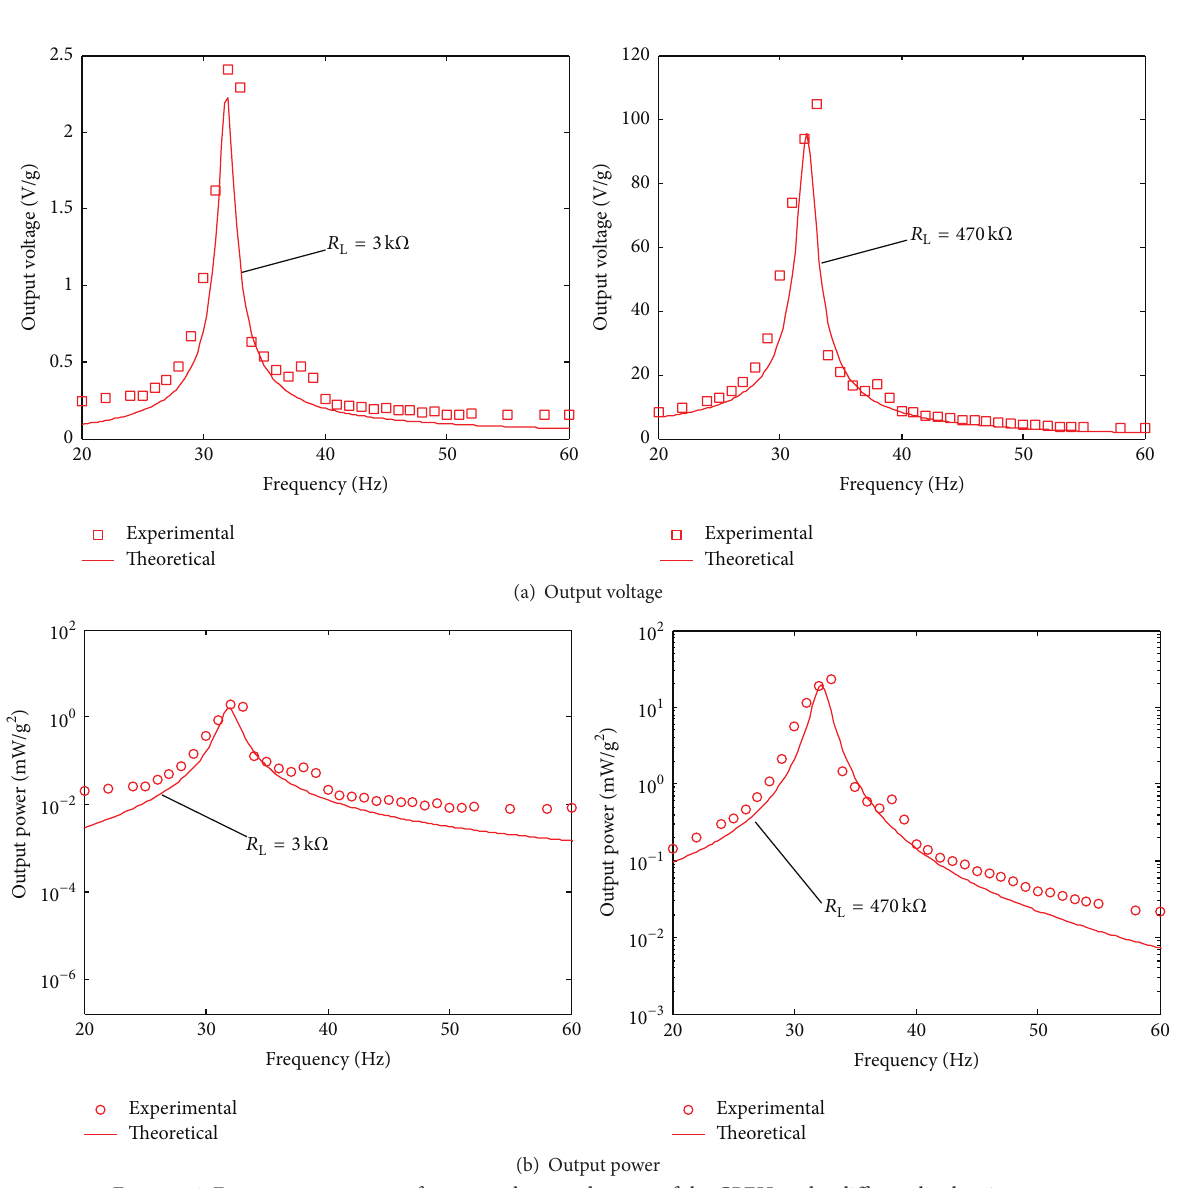
Figure 14: Frequency responses of output voltage and power of the CPEH under different load resistances. Table 3: Measured results of BPEH with different 𝑎 , 𝑟 and load resistances 𝑅